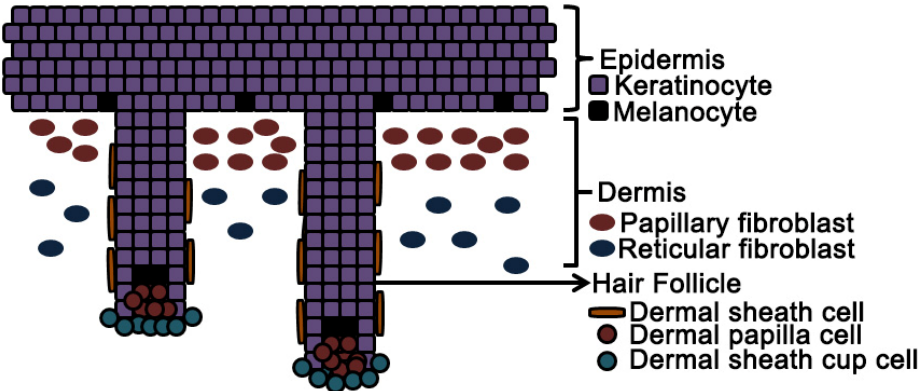
Figure 3. Microanatomic regions of the skin have distinct fibroblast populations which differ in their physical characteristics and functional